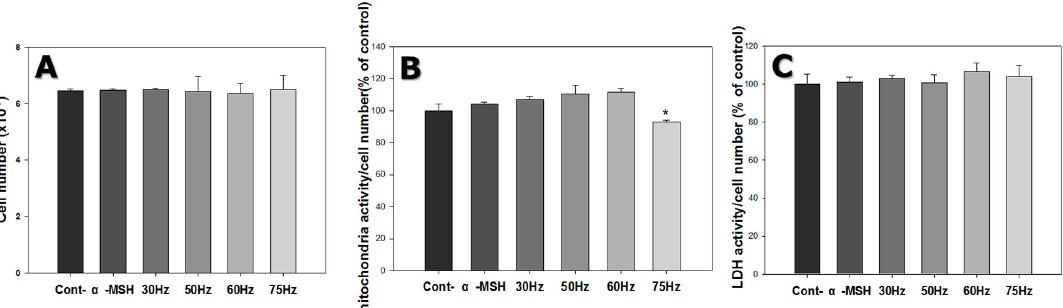
Figure 3. Cell proliferation, mitochondrial activity, and cytotoxicity of melanocytes after 72 h exposure to extremely low frequency electromagnetic fields. ( A ) Cell count (to measure cell proliferation); ( B ) 3-(4,5-dimethylthiazol-2-yl)-2,5-diphenyltetrazolium bromide assay (to determine cell mitochondrial activity); ( C ) Lactate dehydrogenase (LDH) assay (to examine cellular damage). Each bar represents mean ± standard error from independent experiments performed in triplicate ( n = 5). * p < 0.05, compared to the control.